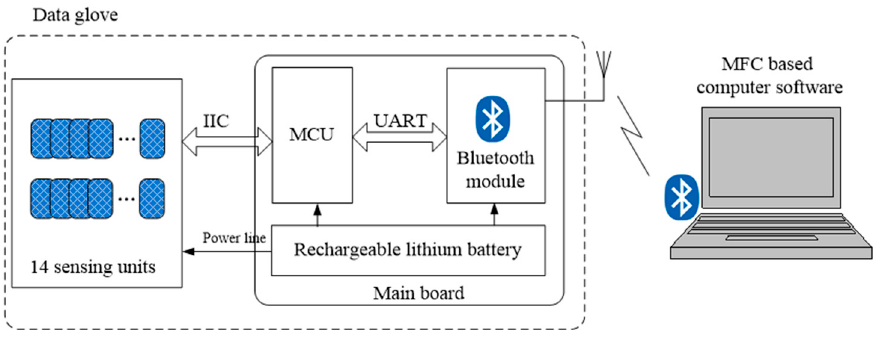
Figure 7. Architecture of the wireless data glove.